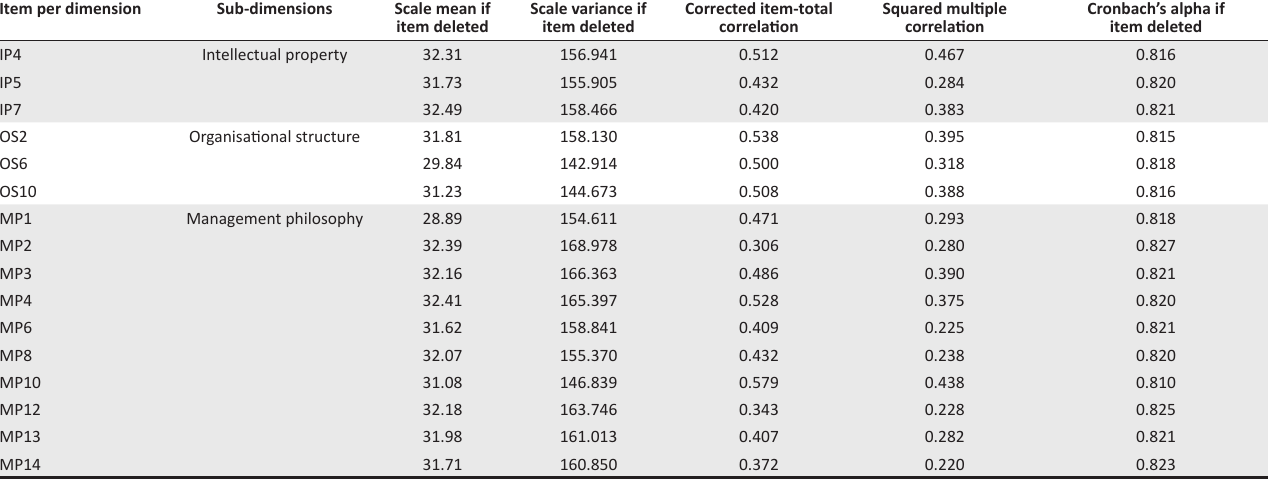
TABLE 5: Iterative item reliability analysis: Structural capital disclosure. Item per